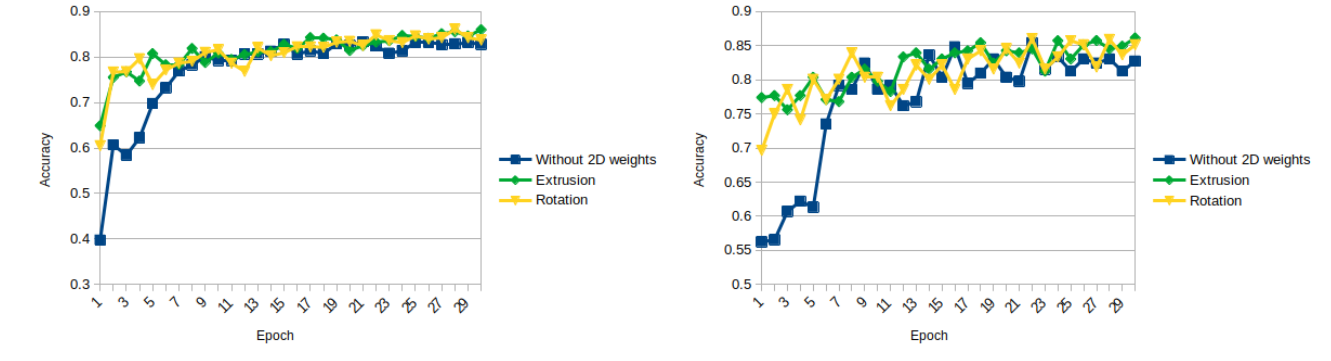
Figure 12. ResNet 3D accuracy.